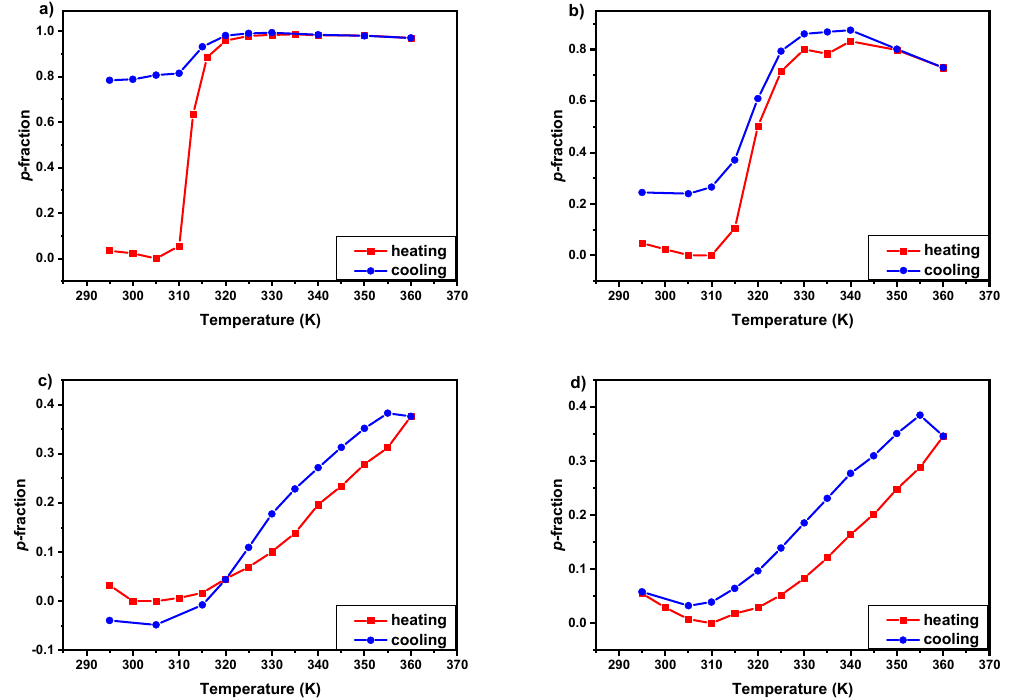
Figure 6. Temperature dependences of the fraction p of units with significantly reduced mobility for NCH 2 protons in D 2 O solutions ( c = 5 wt%) of PIPOx homopolymer ( a ) and P(MeOx / IPOx)(14 / 86) ( b ), P(MeOx / EtOx)(28 / 72) ( c ), P(MeOx / EtOx)(7 / 93) ( d ) copolymers during gradual heating and subsequent gradual cooling.